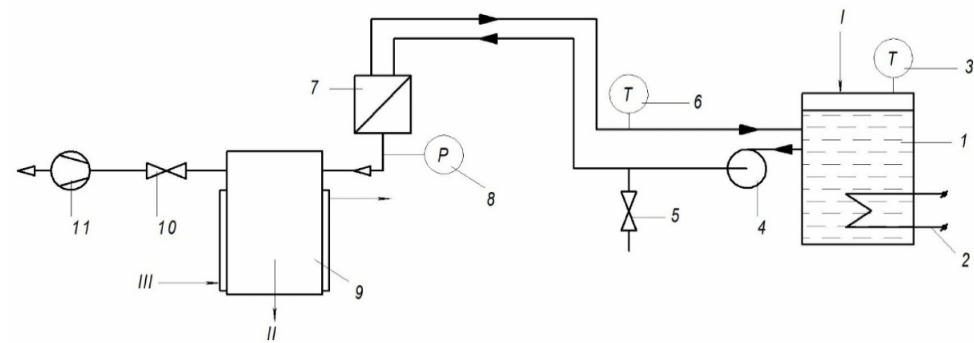
Scheme 1. Schematic representation of the setup for the pervaporation equipment: 1—container for